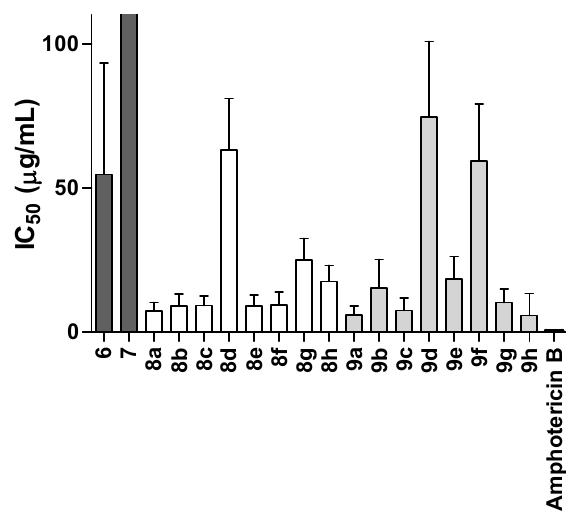
Figure 3. In vitro biological results.